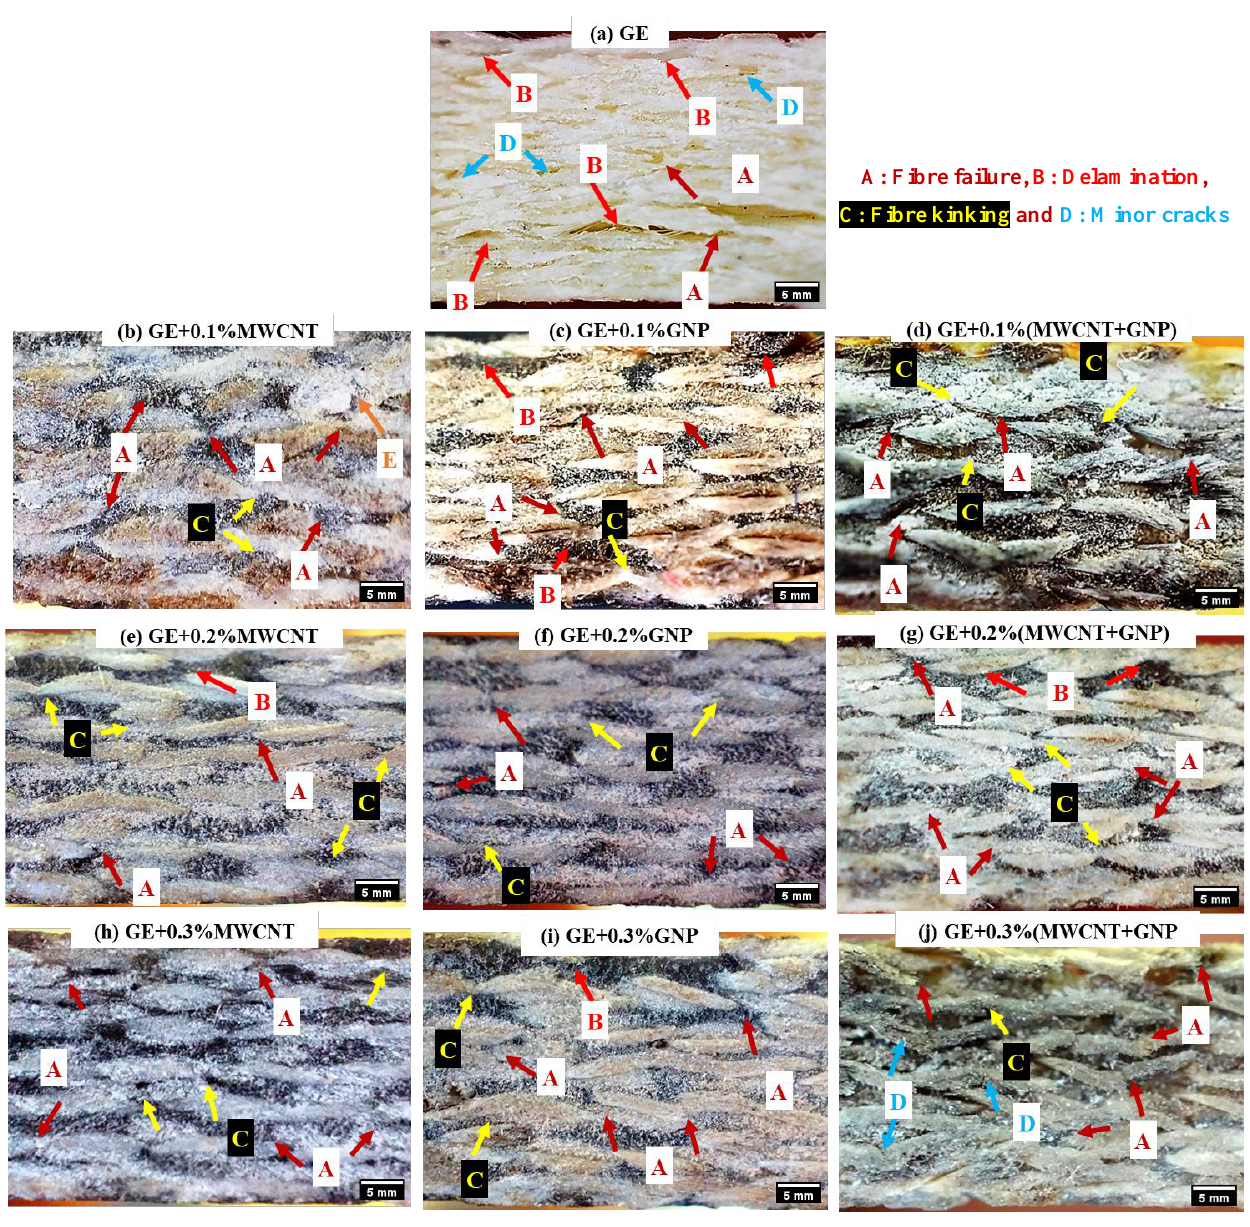
Figure 9. Compressive failure of GE and its nanocomposites (UD).